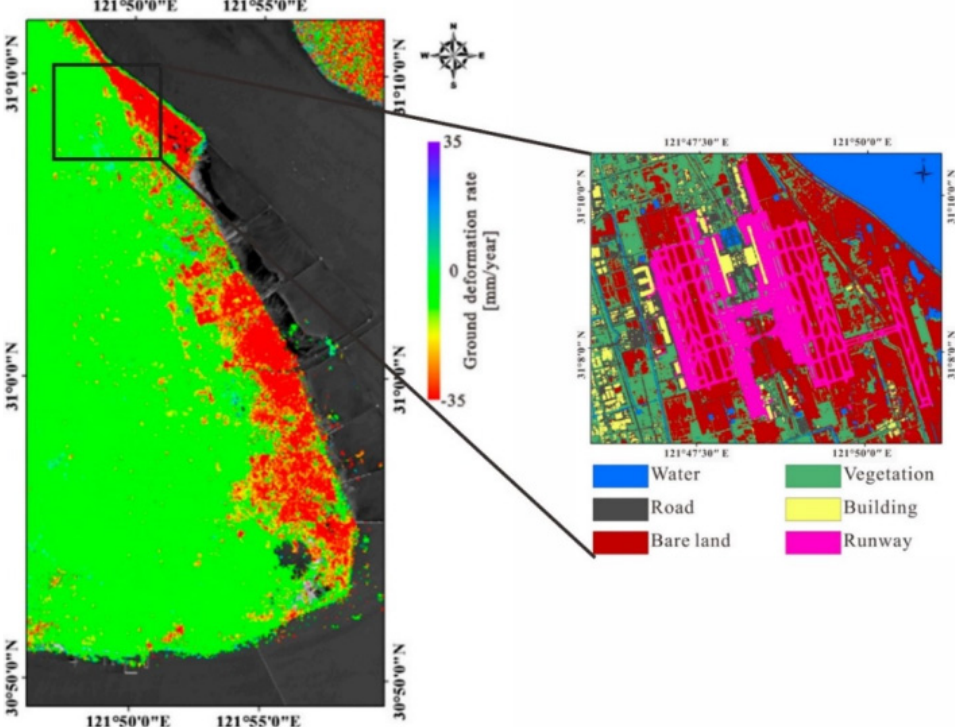
Figure 3. The left image is the interpolated ground deformation rate in the reclamation area (around Pudong airport). The right image is the classification result of multi-source remote sensing data (refer to [27]).